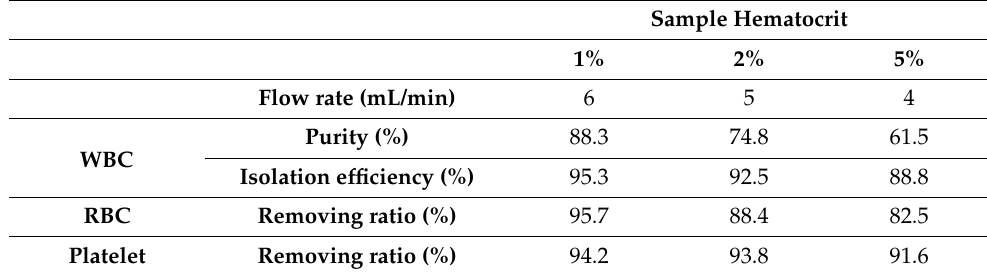
Table 2. Summary of the spiral microchip best performance results in the isolation of WBC, RBC, and Platelets based on the inlet sample flow rate and hematocrit.